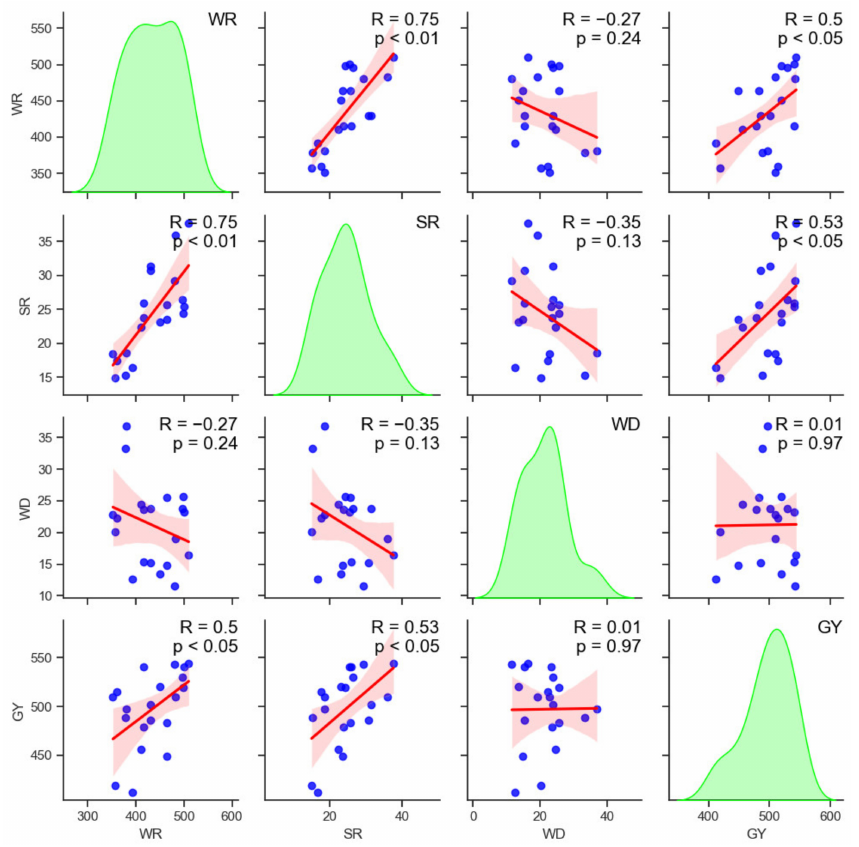
Figure 10. The relationships between the main ecosystem services in the